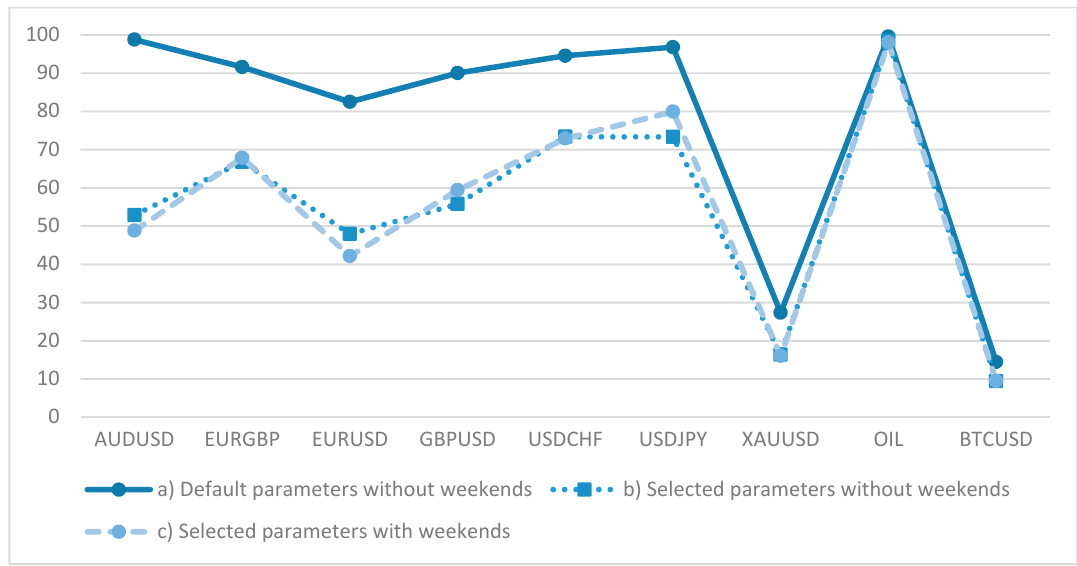
Figure 6. Net Profits of experiments (a), (b), and (c).